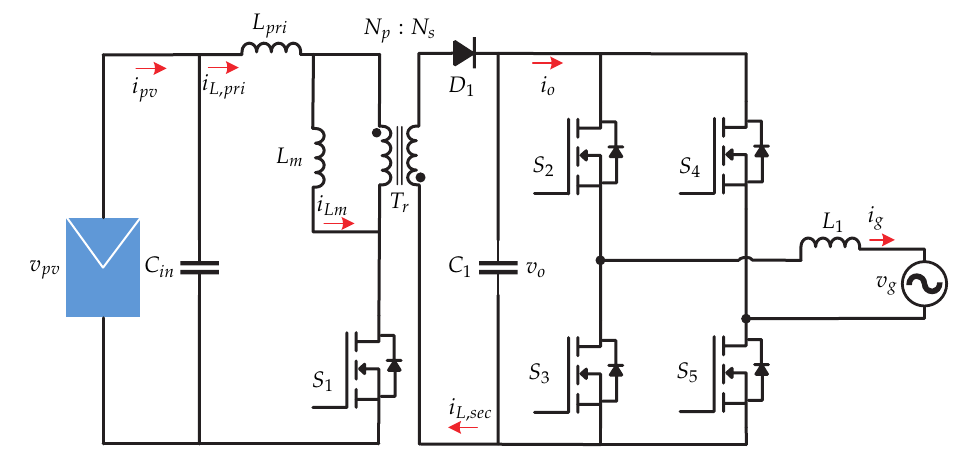
Figure 20. Microinverter’s topology proposed in [29].